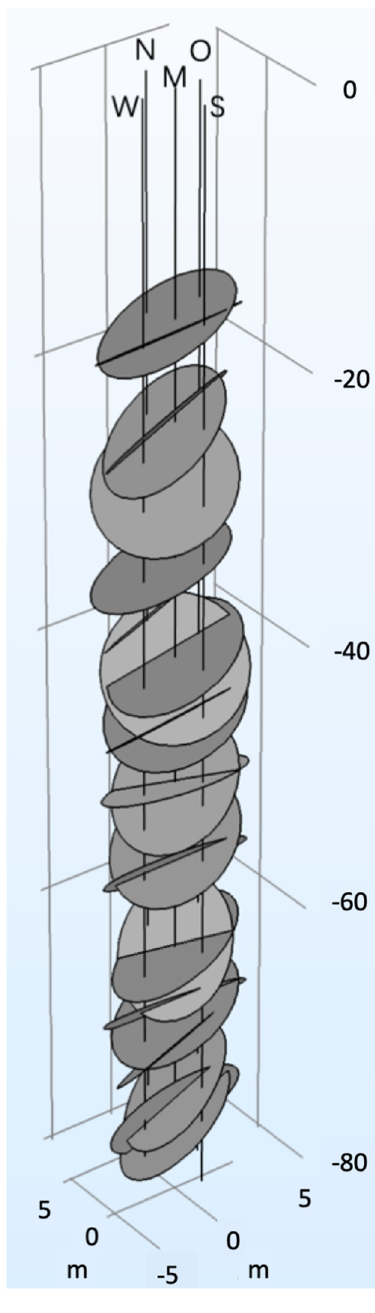
Figure A3. Illustration of the 3D fracture model (gray planes depict the possible positions of fractures) [51].